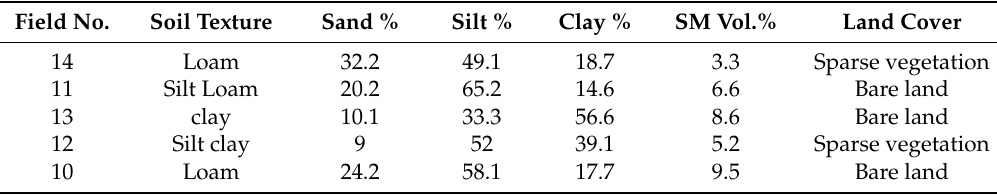
Table 1. Example of physical properties and SM measurement in study